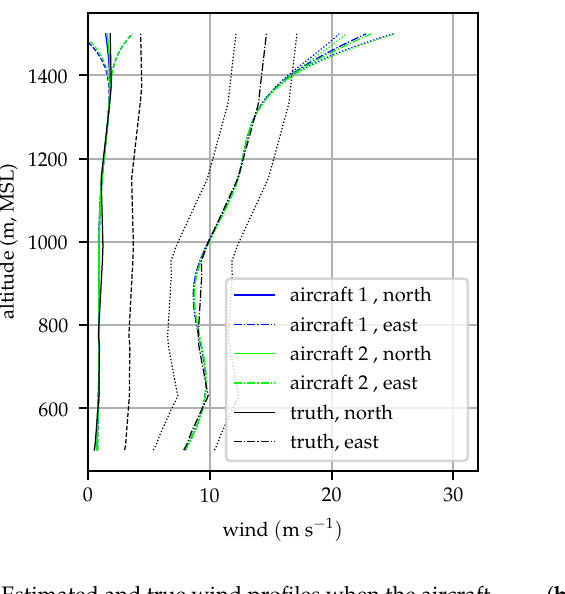
( a ) Estimated and true wind profiles when the aircraft ( b ) Estimated and true solar fraction profile when the have traveled 10 km. aircraft have traveled 10 km. Figure 7. Estimated and true atmospheric profiles and 1 σ bounds at 10 km into the flight for a simulation beginning at 16:00 UTC on 2018-12-03. Error bounds on the true profiles indicate the HRRR skill–the best that the atmospheric state can be known a priori .